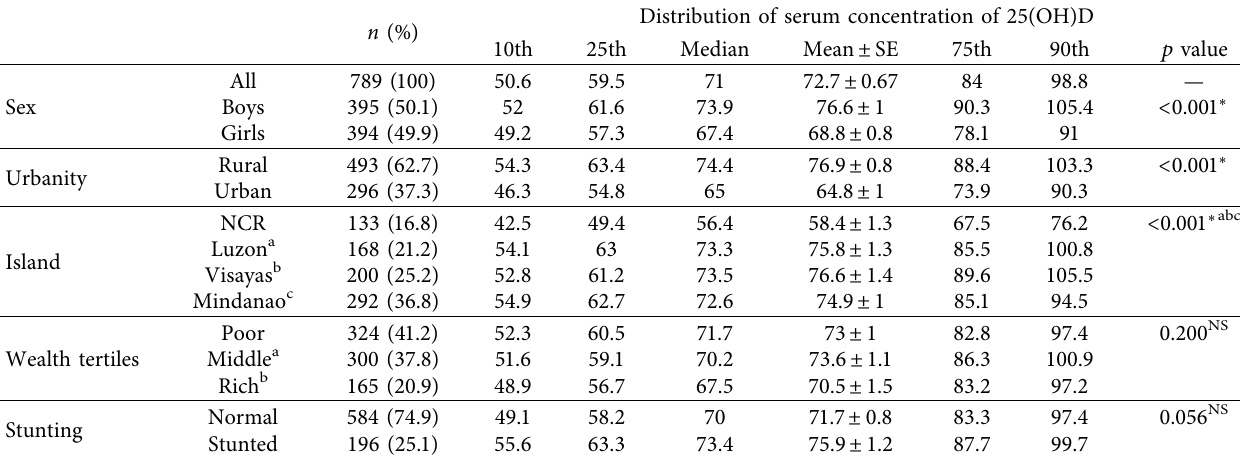
Table 4: Distribution of vitamin D serum level concentration of children.